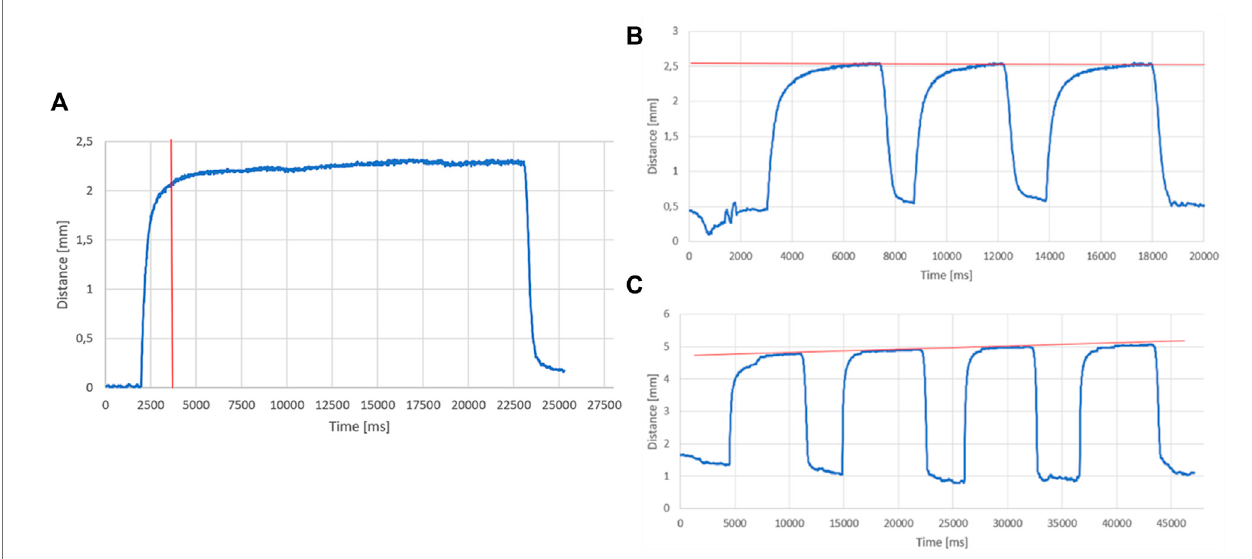
FIGURE 9 | (A) Distance value trend measured by the LPG-D as a function of time; (B) distance trend on silicone specimen; (C) distance trend on healthy skin.